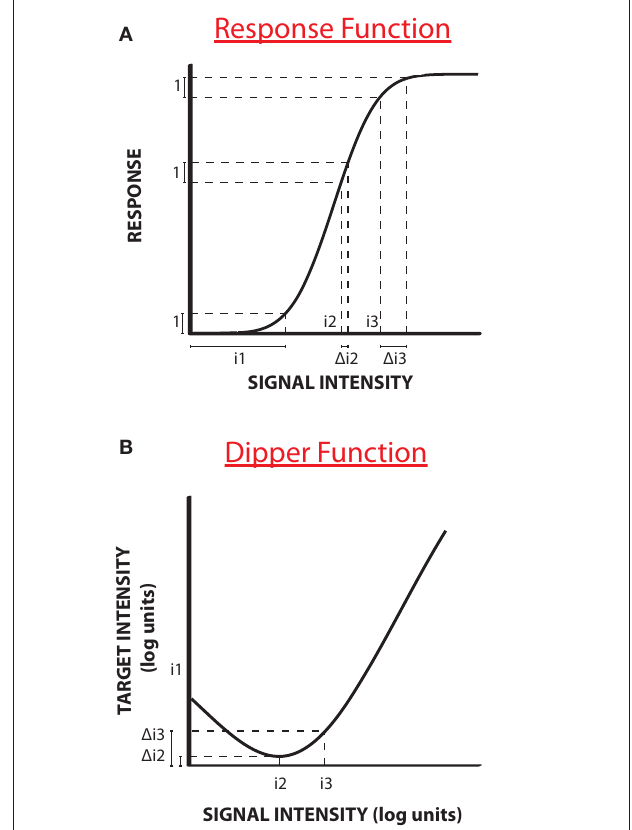
Figure 1 | response function and dipper function. (A) A stylized “dipper function”: adding a small quantity of signal improves thresholds, but higher levels of base intensity increases them. (B) The dip is usually explained by a purported non-linearity in the function that transduces signals into neural responses. The function has an initial threshold-like, accelerating non-linearity and a later compressive non-linearity. If we assume that to perceive two stimuli to be different requires a constant change in responsiveness (illustrated by the dotted lines), then more contrast is required to achieve this change at the lower and higher ends of the curve than in the middle, where the curve is steepest: the lower contrasts at the steep part of the curve cause the